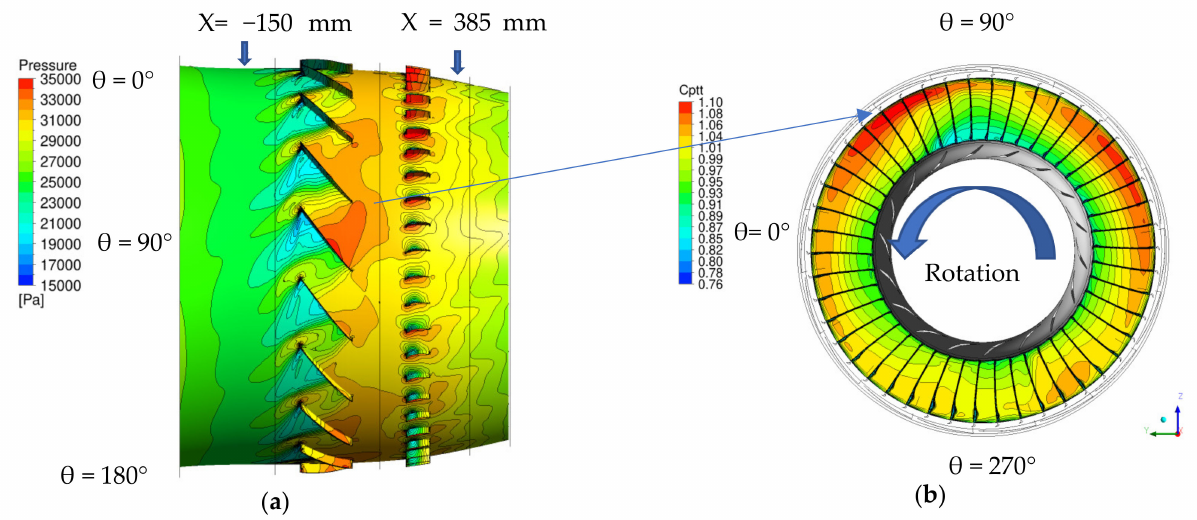
Figure 8. ( a ) Static pressure field at one instant; ( b ) total pressure coefficients over a plane downstream of the outlet guide vane (OGV) X = 385